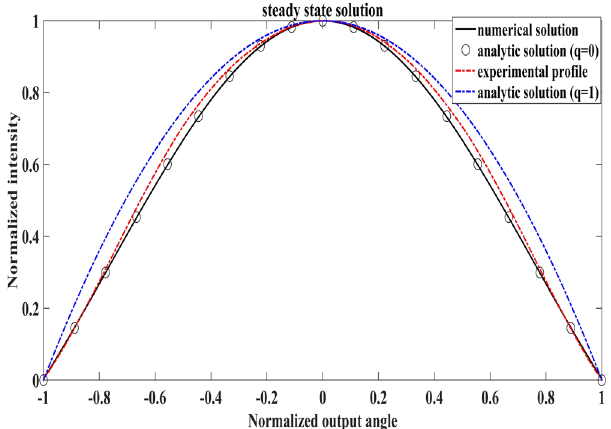
Figure 6. Numerical, analytic and experimental beam profiles under the steady state solution. q is the angle dependence order of d ( θ ). Experimental profile lies between the theoretical profiles when q = 0 and q = 1. q = 0 was chosen for numerical simplicity in our